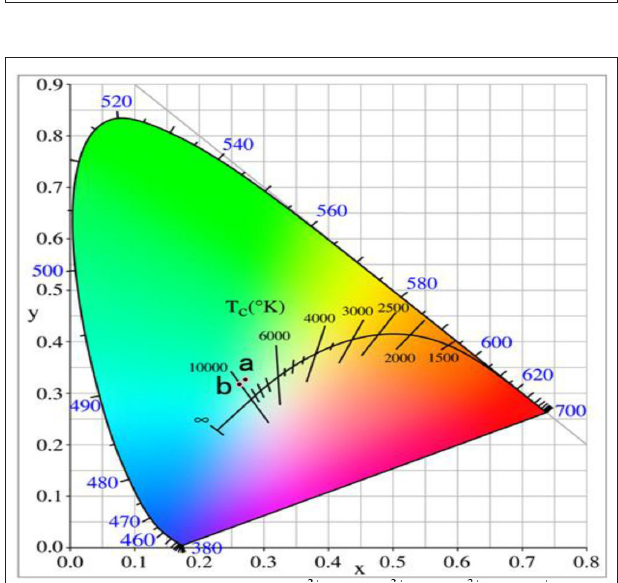
FIGURE 11 | Chromaticity coordinates of the GdAlO 3 :0.6%Er 3 + , 16%Yb 3 + , 1%Tm 3 + , z% Li + phosphors (1: z = 0; 2: z = 2).